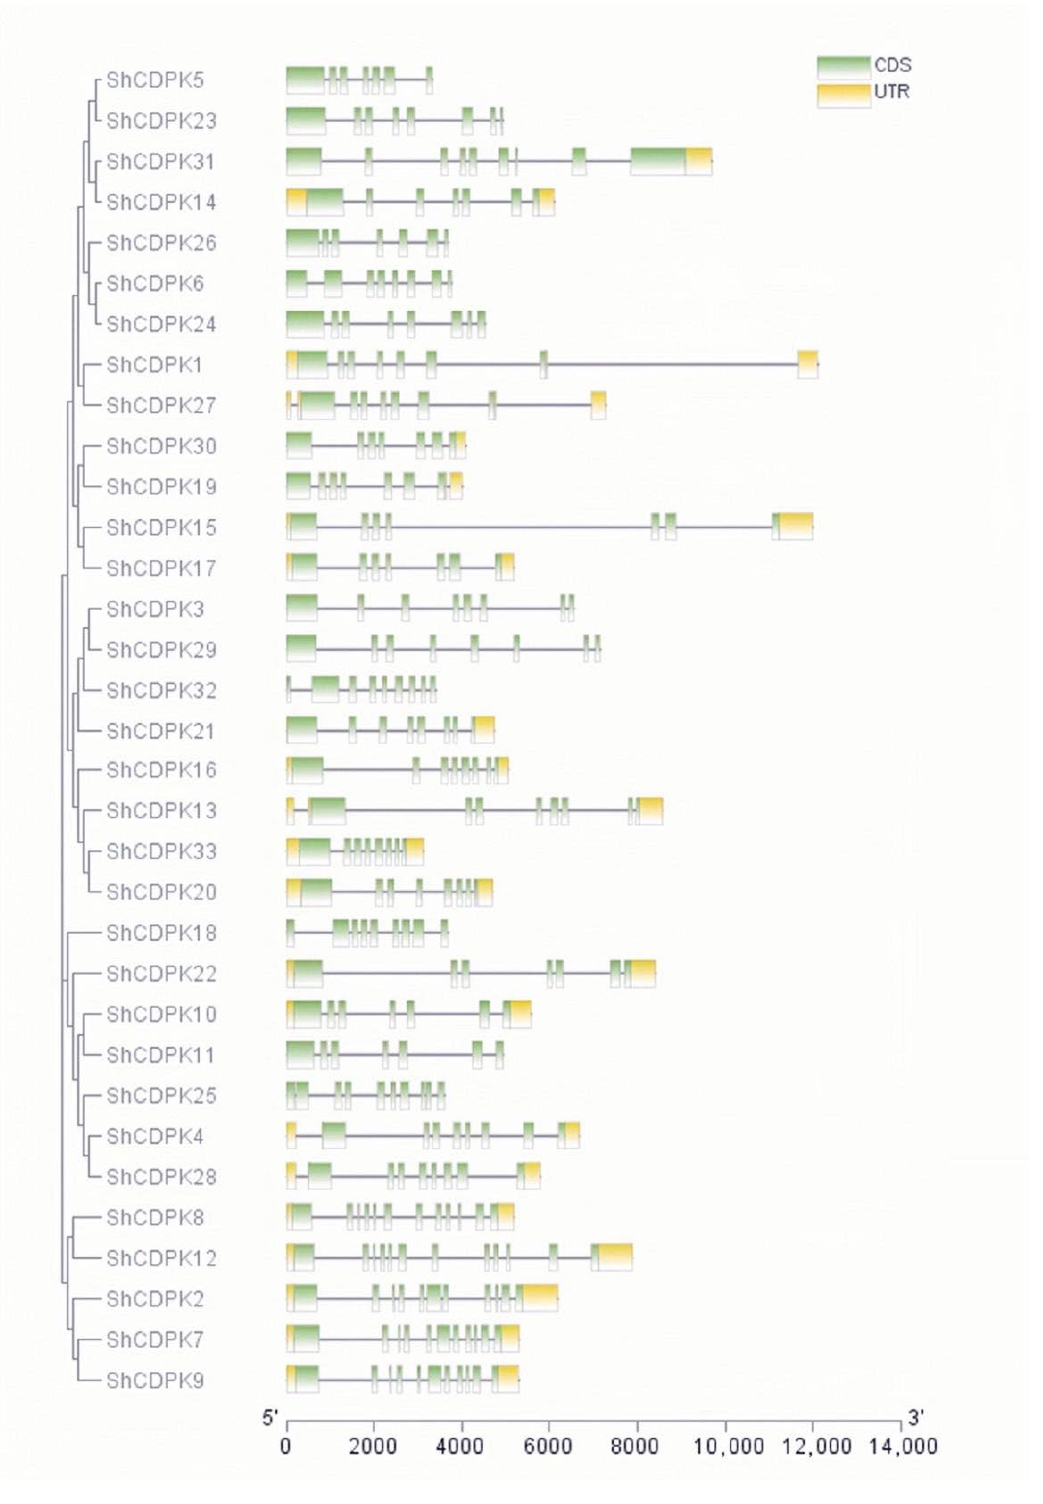
Figure 2. Exon and intron structure analysis of CDPK gene family in Solanum habrochaites .